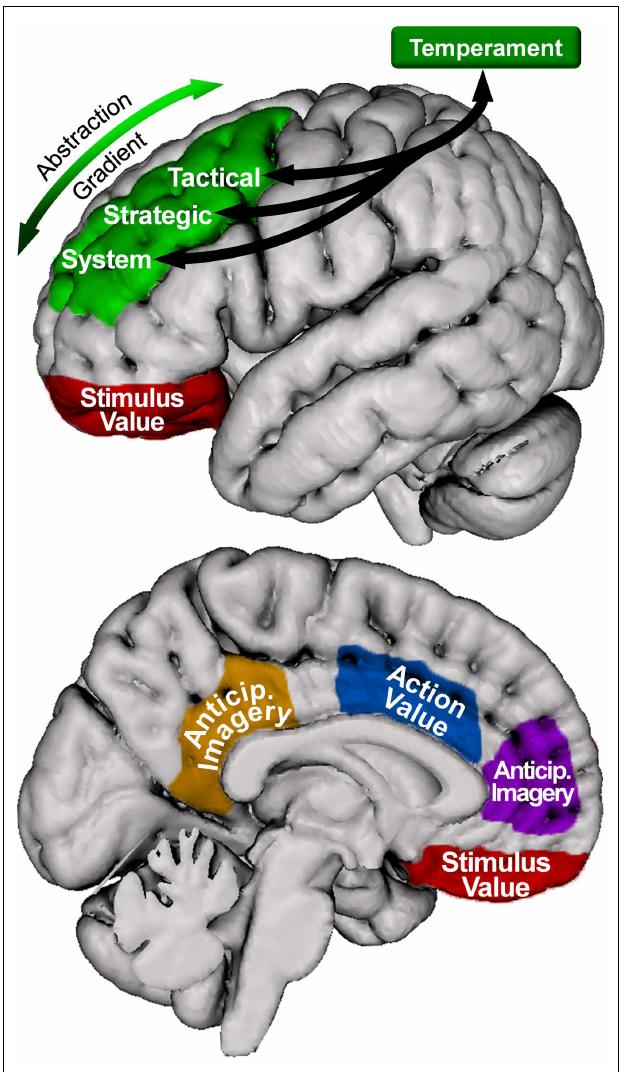
FIGURE 3 | Motivational organization of superior, lateral prefrontal cortex, and relationship with other brain areas in the model . Green = superior, lateral prefrontal cortex. Blue = anterior cingulate cortex. Red = orbitofrontal cortex. Purple = medial prefrontal cortex. Orange = posterior cingulate cortex. Only left hemisphere is shown; right hemisphere is similarly organized.The location and coverage of the areas is meant to represent a relative placement rather than a delineation of specific